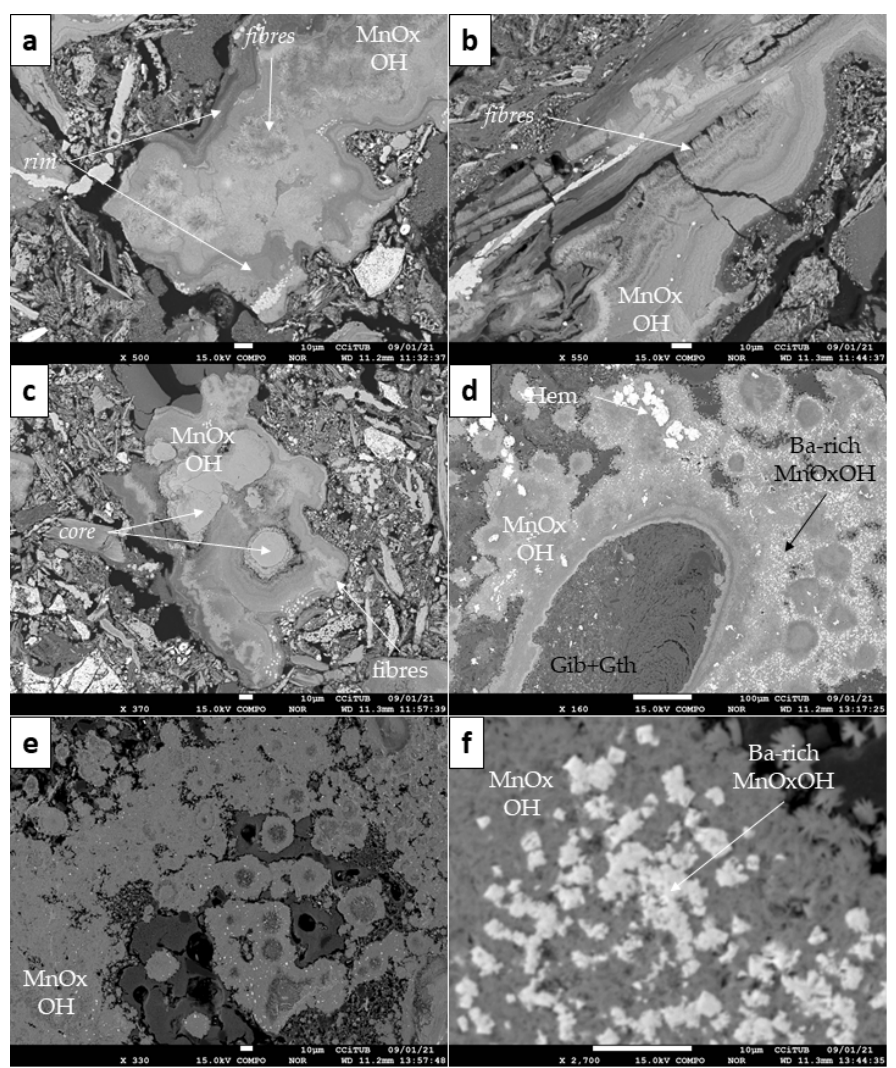
Figure 7. Back-scattered electron (BSE) photomicrographs of the Mn-oxyhydroxide textures identified in Loma Caribe (Dominican Republic) samples: ( a – c ) colloform aggregates including distinct features (rims, core and fibres; see text for explanation); ( d , e ) globular spherulitic aggregates with a gibbsite and goethite (Gib + Gth) core ( d ), and as small, isolated spherulitic aggregate particles ( e ); ( f ) Ba- rich angular grains within the globular spherulitic aggregates. Note the flaky appearance of the Mn-oxyhydroxides in the background in ( f